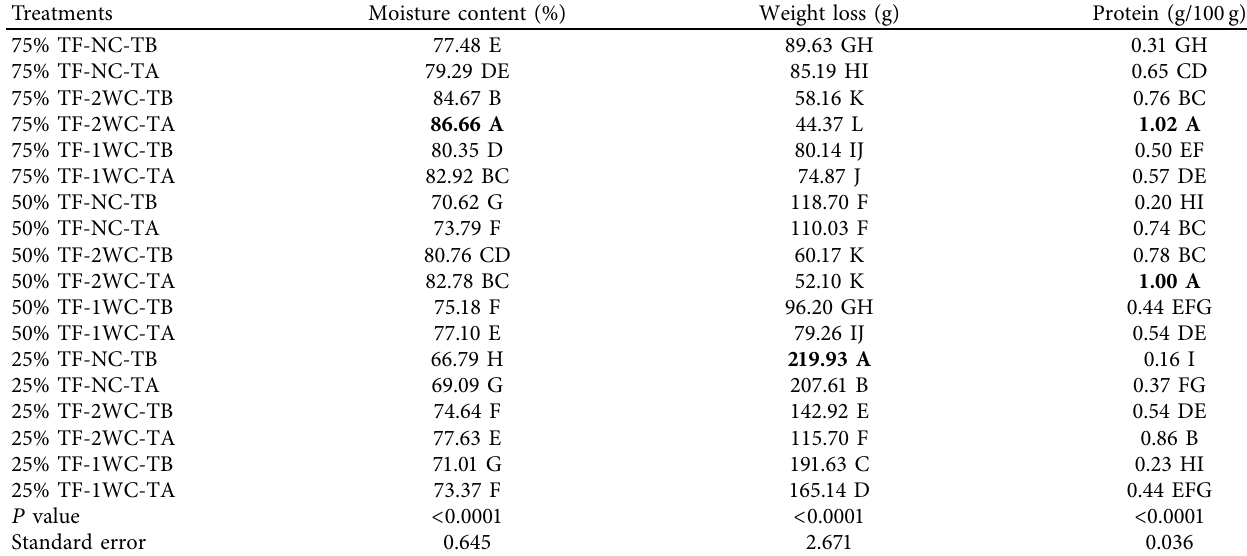
Table 2: Treatment effect on proximate analysis of stored bulb onions Treatments